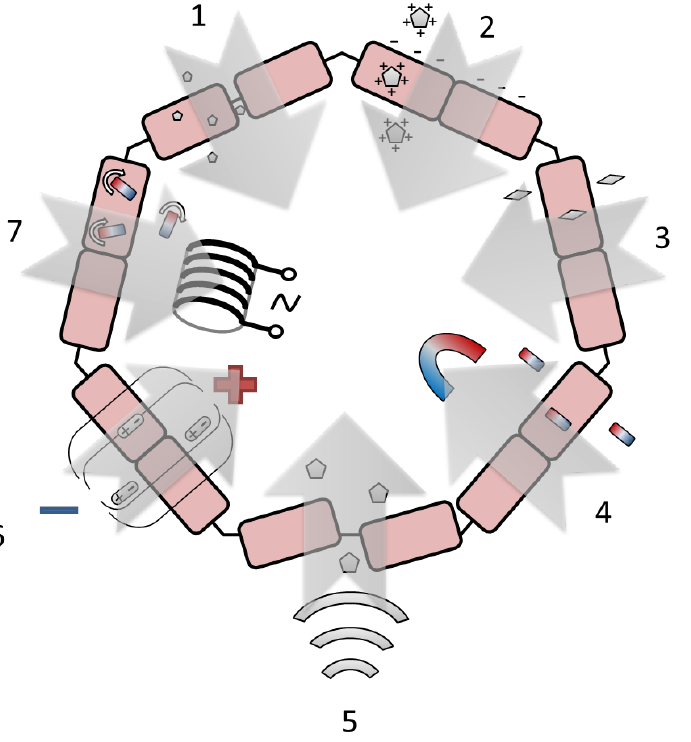
Figure 4. The most frequently proposed approaches to enhance the histohematic barrier permeability: 1—NP size reduction, 2—NP surface charge modulation, “+” and “–” conditionally designate various surface charge, 3—NP shape modulation, 4—magnetic-field-enhanced permeation, 5—the effect of focused ultrasound, 6—electroporation, “+” and “–” designate electrical poles, 7—the effect of electromagnetic radiation, rounded arrows indicate the rotation of NPs under the action of an alternating field created by an electromagnetic coil.